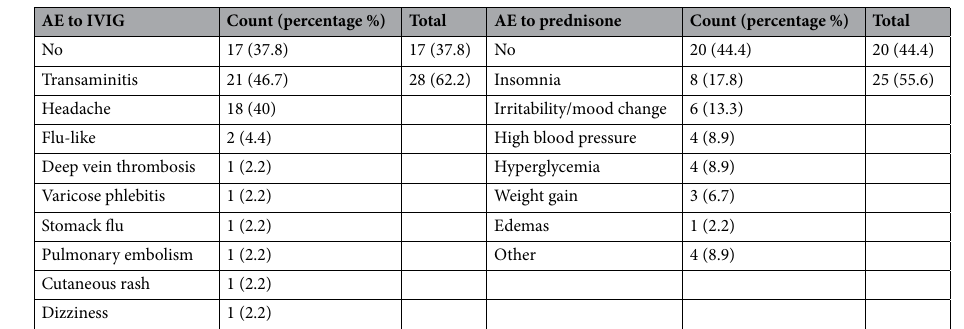
Table 2. Advers effects (AE) to intravenous immunoglobulins (IVIg) and prednisone.